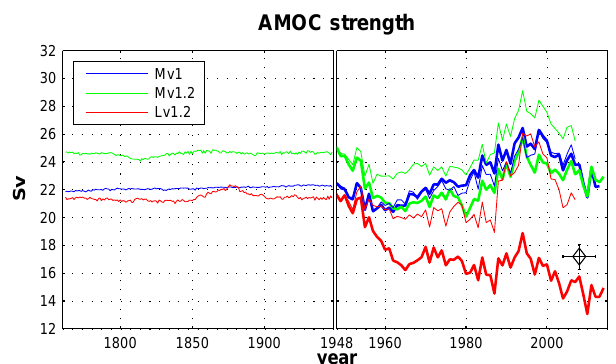
Figure 3. Atlantic Meridional Overturning Circulation (AMOC) measured as the maximum of the meridional stream-function at 26.5 ◦ N for Mv1 (blue lines), Mv1.2 (green), and Lv1.2 (red). The left panel shows the AMOC for the period 1762–1947 during which the model is forced with the CORE normal-year forcing. In the right panel the years 1948–2014 are shown, and thick (thin) lines indi- cate the overturning simulated with the model forced by the NCEP- C-IAF (CORE-IAF) data set. The black diamond with error bars indicates the observational estimate provided by McCarthy et al.